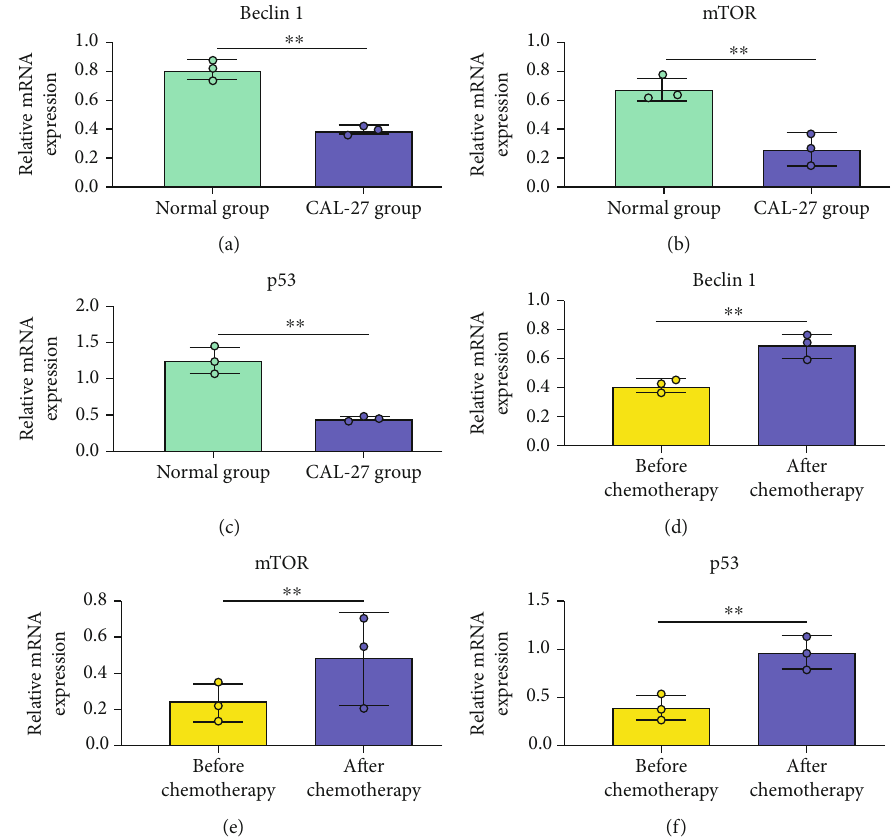
Figure 2: Detection of autophagy activity by PCR. (a) Beclin mRNA expression; (b) mTOR mRNA expression; (c) P53 mRNA expression; (d) changes of Beclin1 mRNA expression after chemotherapy; (e) changes of mTOR mRNA expression after chemotherapy; (f) changes of P53 mRNA expression after chemotherapy; ∗∗ P < 0 : 01